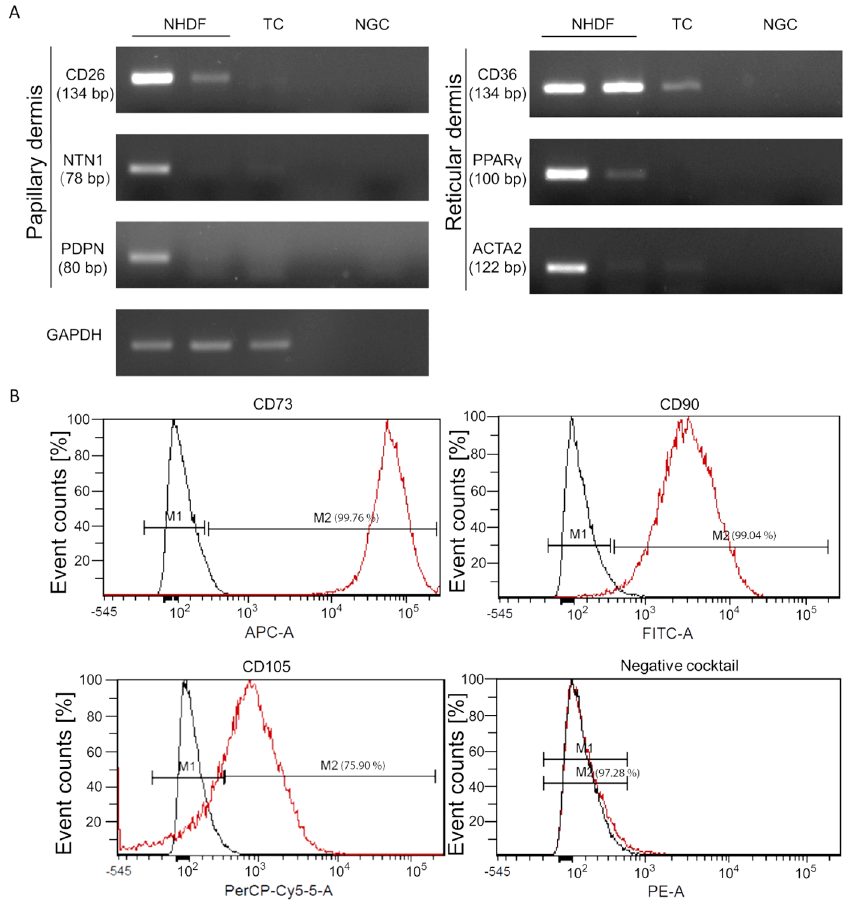
Figure 1. Brief characterization of commercial NHDFs. Expression analyses of ( A ) papillary and reticular dermis gene markers in normal human dermal fibroblasts (HDFs, n = 2) and tendon-derived cells (TC, n = 1) using semi-quantitative PCR analysis, and ( B ) MSCs (CD73, CD90 and CD105) and hematopoietic cell markers (negative cocktail for HLA-DR, CD11b, CD19, CD34 and CD45) in one representative NHDF donor (n = 1) by FACS.